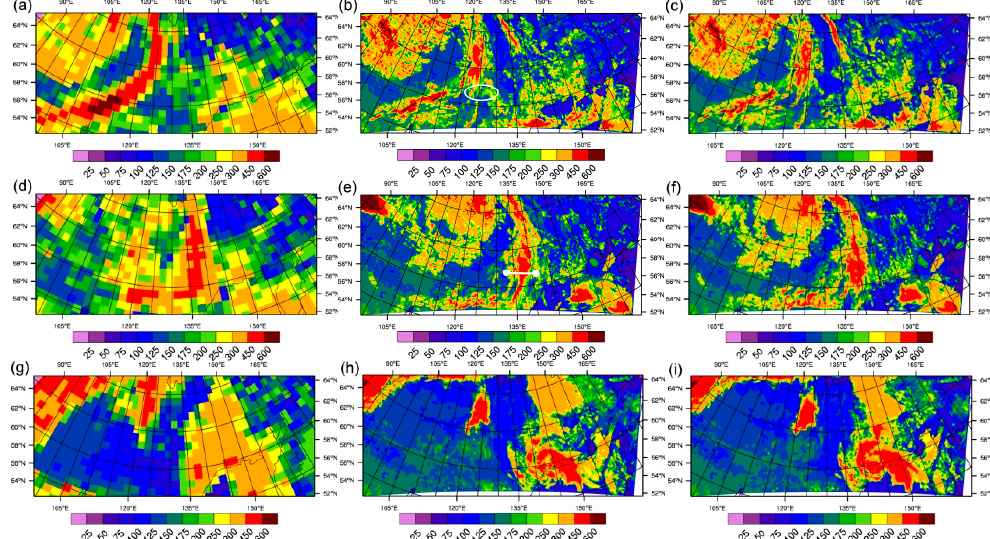
Figure 5. ( a ) SRB SW TOA ↑ , ( b ) SW TOA ↑ modeled by SMOKE and ( c ) CLEAN during FP1 at 0600 UTC on 9 August 2002. ( d ) SRB SW TOA ↑ , ( e ) SW TOA ↑ modeled by SMOKE and ( f ) CLEAN during FP1 at 0600 UTC on 10 August 2002. ( g ) SRB SW TOA ↑ , ( h ) SW TOA ↑ modeled by SMOKE and ( i ) CLEAN during FP1 at 0600 UTC on 11 August 2002. The white circle on ( b ) indicates the regions with large number of fires. The white line on ( e ) shows the cross-section as discussed in Figure 6.